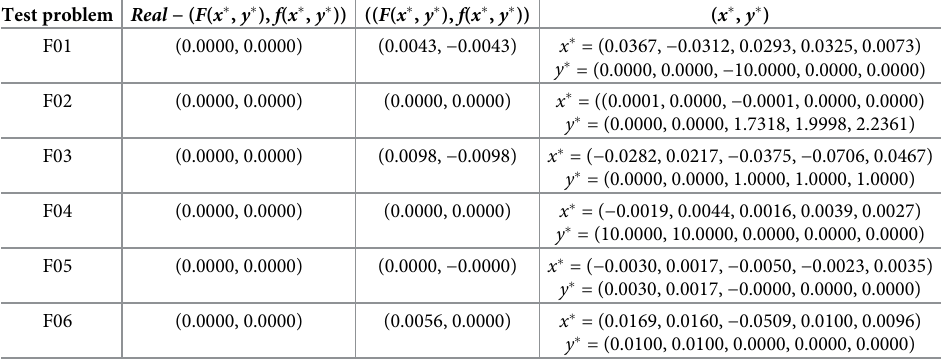
Table 2. Comparison between the results obtained by TCEA and the real objective values in the case of 10 dimensions.